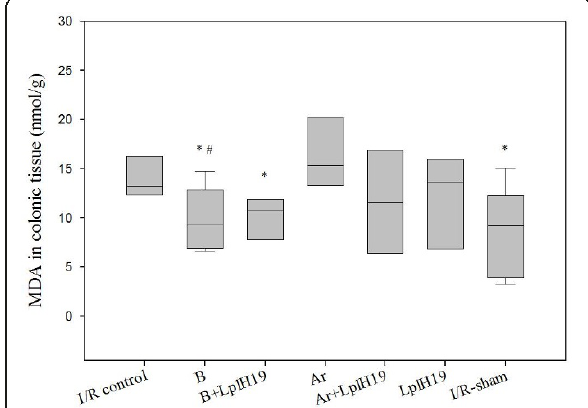
Figure 2 Effects of experimental diets on lipid peroxidation in colon after intestinal ischemia-reperfusion . The figure shows effects of billberry (B), chokeberry (Ar) and/or strain Lactobacillus plantarum HEAL19 (LplH19) administration on lipid peroxidation in colonic tissue. Significant decrease of lipid peroxidation (MDA) was observed in B-group (*p = 0.030), B+LplH19-group (*p = 0.021) and I/R-sham (*p = 0.014) compared to the I/R-control. A significantly lower MDA-value was also noted in B-group compared to Ar-group (#p = 0.016). Median values are indicated by the transverse line within the box and the top and bottom lines of each box represent the 25 th and 75 th